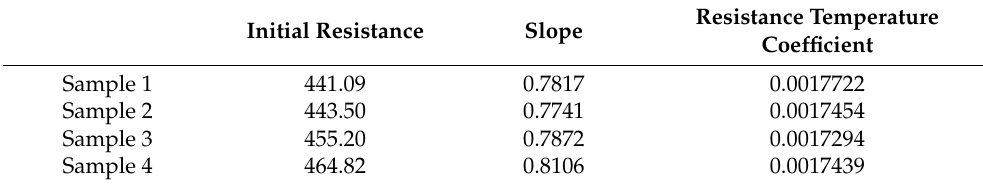
Table 1. Resistance–temperature coefficient calibration of four Pt film sensing units. Resistance Initial Resistance Slope